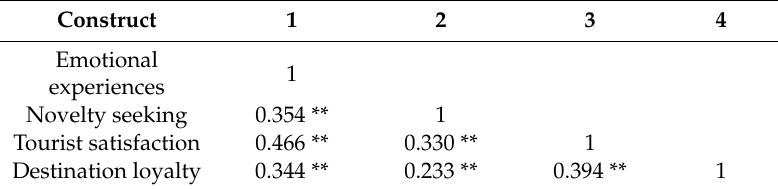
Table 2. Correlations between